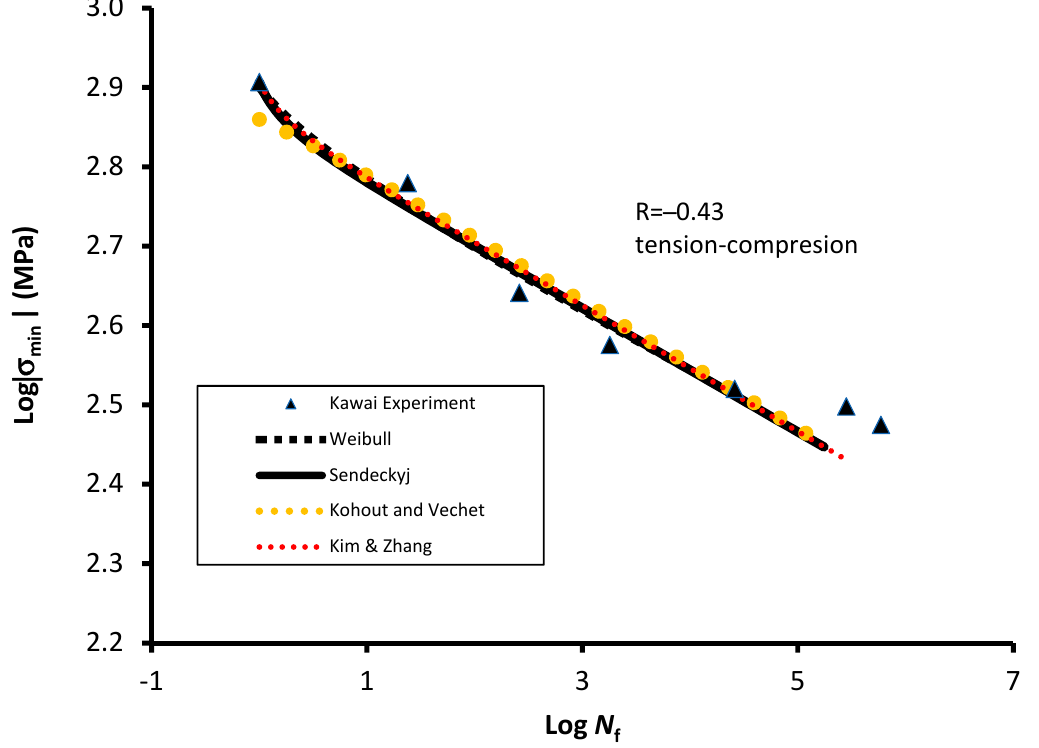
Figure 7. Kawai and Itoh experiment [22] with σ uC = 807 MPa and σ uT = 1887 MPa with S-N curves obtained from: Weibull model with α = 2.5 × 10 − 1 and β = 0.83, and assumed σ ∞ = 0; Sendeckyj model with α = 4.485 and β = 0.078; Kohout and Vechet model with α = 0.35and β = − 0.08; and Kim and Zhang model with α = 2.884 × 10 − 160 , β = 54.388 and N 0 = 1.